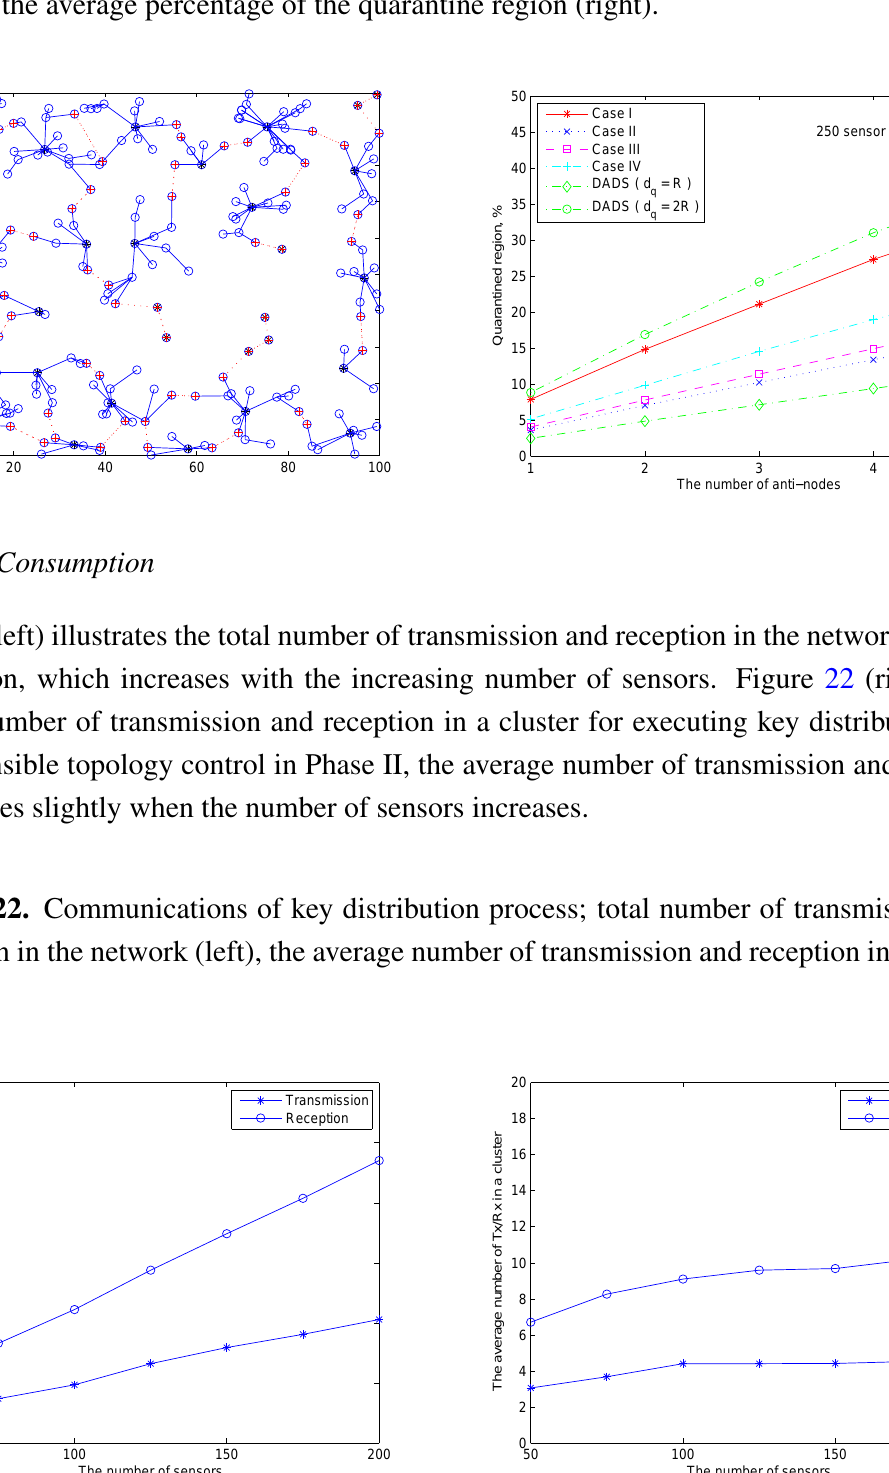
Figure 21. A random network of 250 sensors deployed based on sensor deployment strategy II (left); the average percentage of the quarantine region (right).